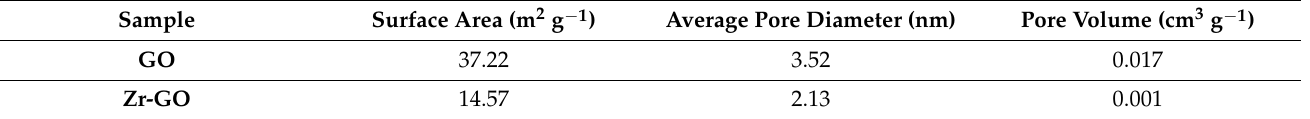
Table 1. Summary of surface area, pore volume and average pore diameter of GO and Zr-GO.